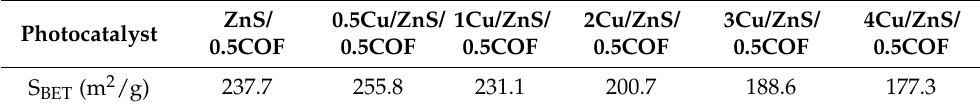
Table 1. Specific surface area (S BET ) of Cu/ZnS/COF composite photocatalyst.